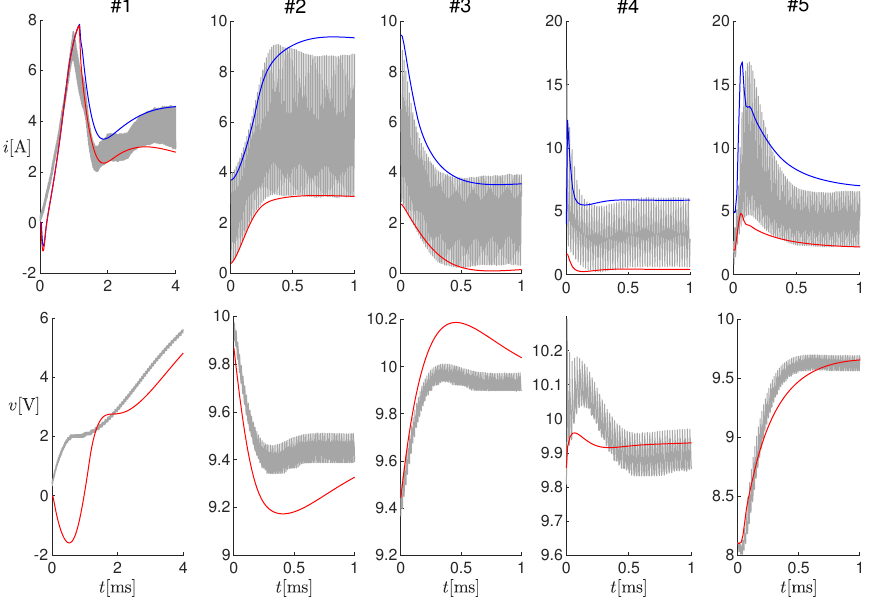
Figure 6. Enlargements of the panels in Figure